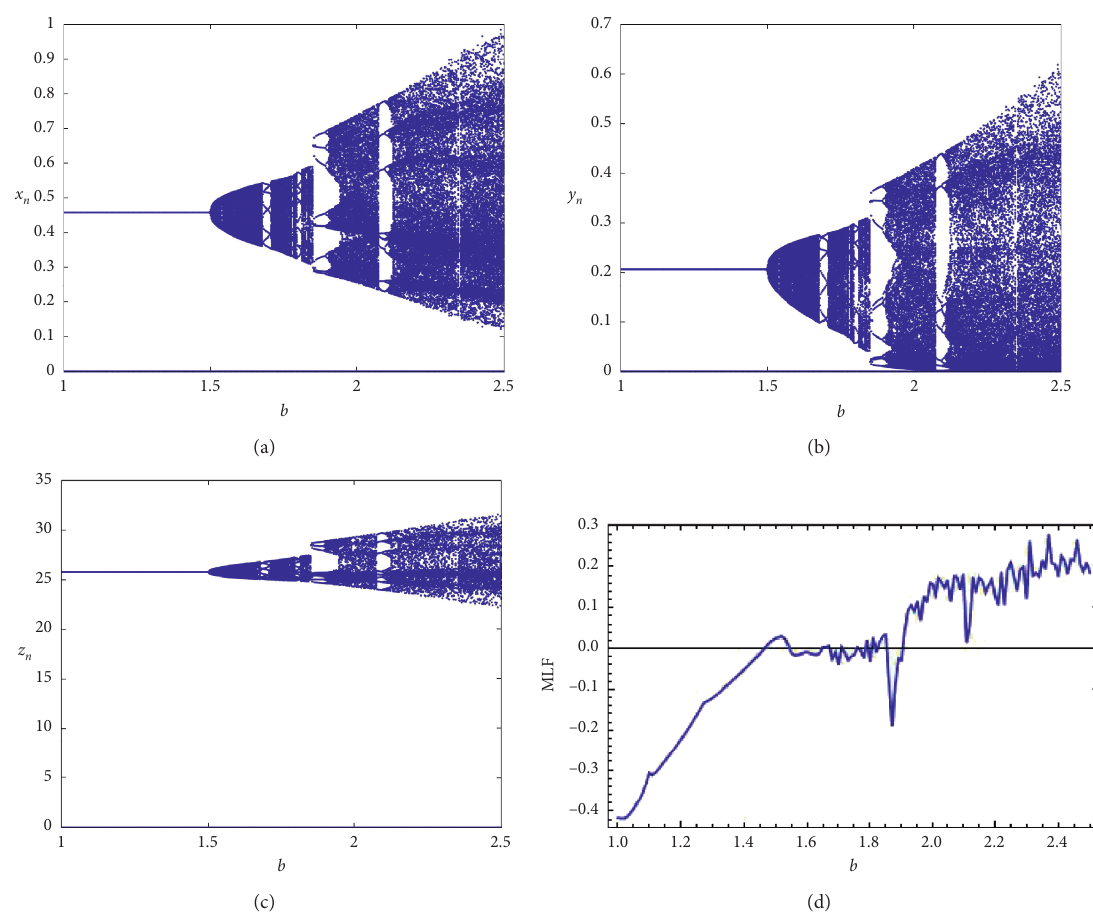
Figure 6: Bifurcation diagrams and MLE for system (2) with r � 5 . 2, k � 1 . 01, α � 4 . 3, β � 2 . 9, a � 0 . 1, c � 0 . 45, d � 0 . 11, δ � 2 . 8, m � 3 . 9, η � 1 . 5, b ∈ [ 1 , 2 . 5 ] , and initial conditions ( x (c) Bifurcation diagram for z n . (d) Maximum Lyapunov